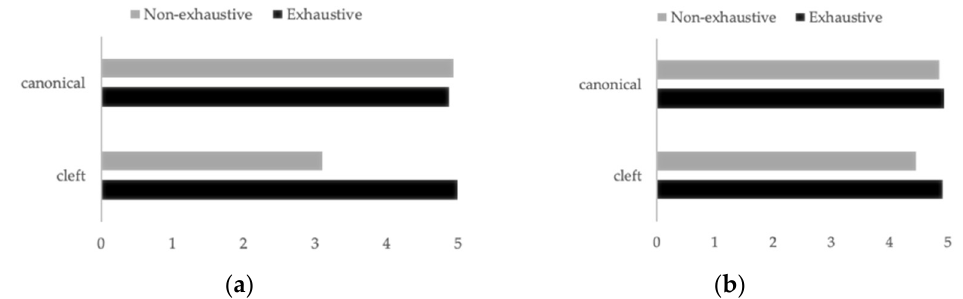
Figure 4. Average ratings for clefted and canonical questions per picture type. ( a ) Native speakers; ( b ) L2 learners.